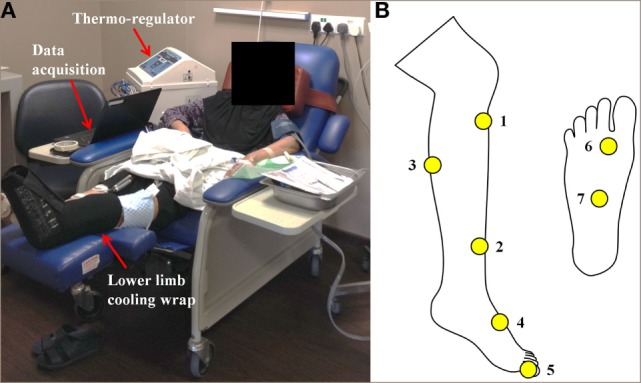
(A) Continuous-flow limb hypothermia setup by means of a thermoregulator device supplying coolant (water) at a set desired temperature (22°C) to limb wraps that cool the limb. Continuous skin temperature data are acquired via a temperature monitoring system consisting of wireless sensors placed at seven different sensor locations on the cooled and control legs as indicated in (B), which transmit data wirelessly to a receiver and recorded for analysis.